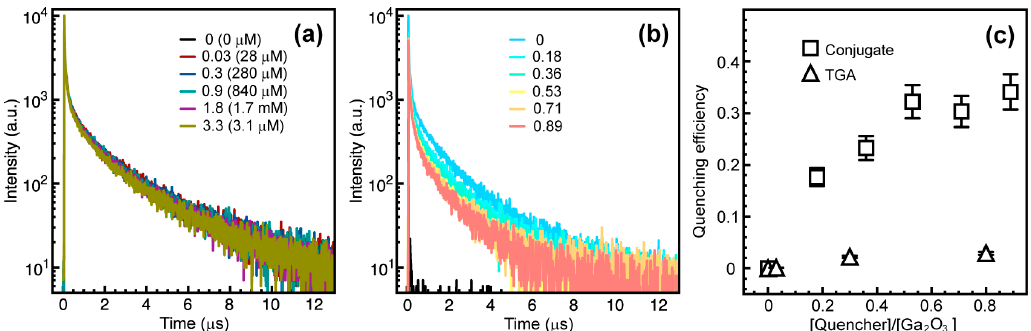
Figure 5. ( a ) Time-resolved DAP PL decay of Ga 2 O 3 NCs containing different amounts of surface-bound TGA without CdSe/CdS NCs. TGA equivalents and absolute concentrations (in parentheses) in Ga 2 O 3 NC suspensions are indicated in the graph (aqua blue trace (0.84 mM) represents TGA concentration for the highest acceptor to donor ratio); ( b ) Time-resolved DAP PL decay of Ga 2 O 3 NCs in the NC conjugates having different CdSe/CdS to Ga 2 O 3 NC concentration ratio, as indicated in the graph; ( c ) Quenching efficiency of the DAP PL of Ga 2 O 3 NCs in the NC conjugate (squares) and with bound TGA (triangles).